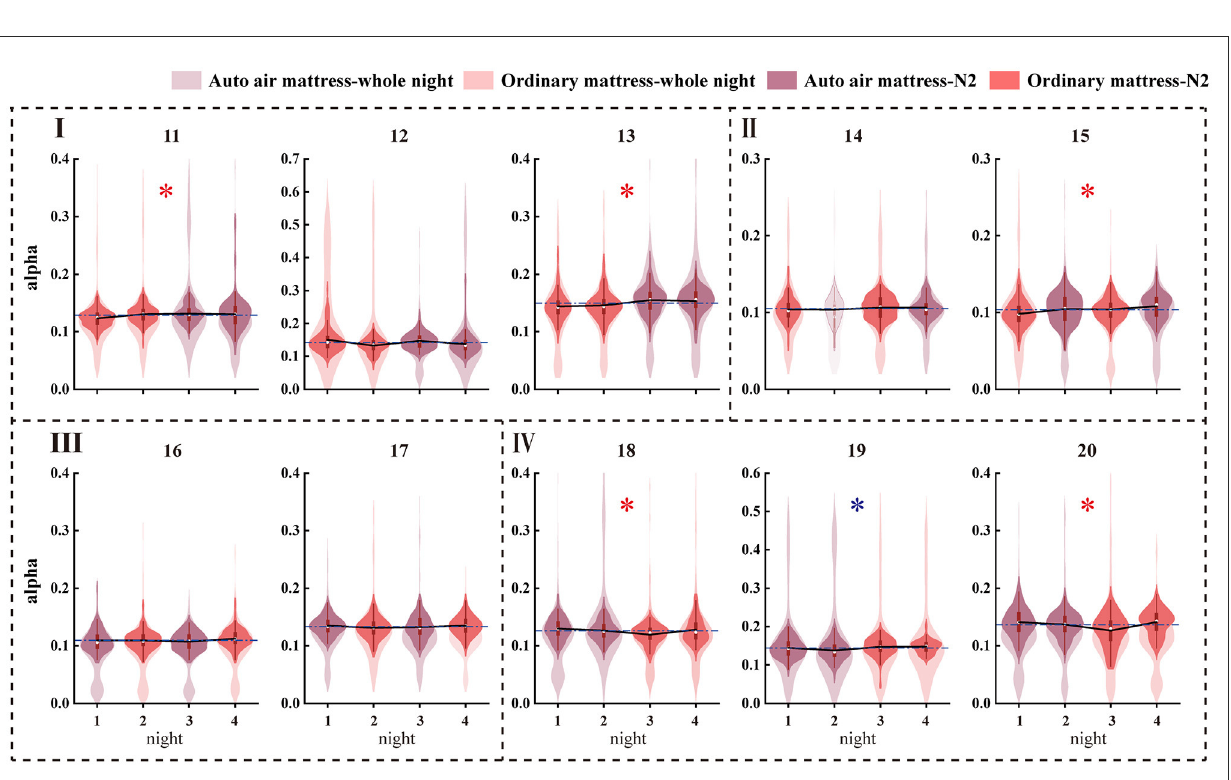
FIGURE6 The alpha power distribution of the whole night and the N2 sleep of the female participants. Red star and blue star indicate that the auto air mattress increases relative alpha power and decreases alpha relative power, respectively.